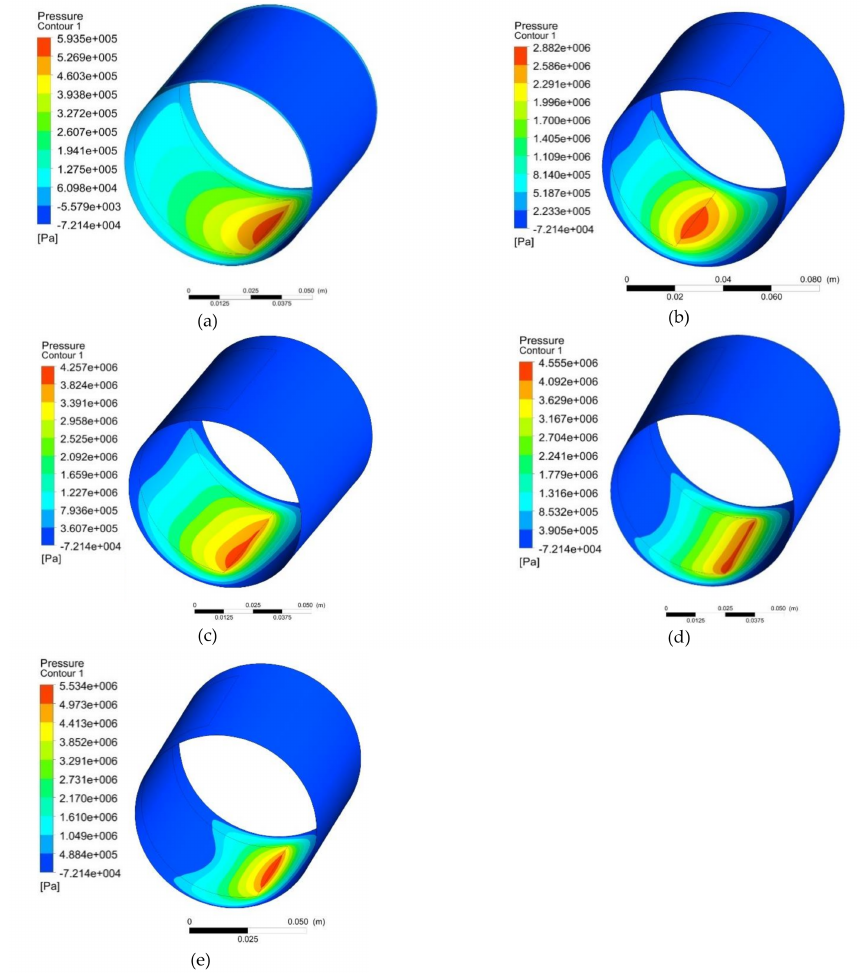
Figure 14. Hydrodynamic pressure contour of the heterogeneous slip/no-slip bearing for various rotational velocity: ( a ) n = 100; ( b ) n = 500; ( c ) n = 1000; ( d ) n = 3000; ( e ) n =